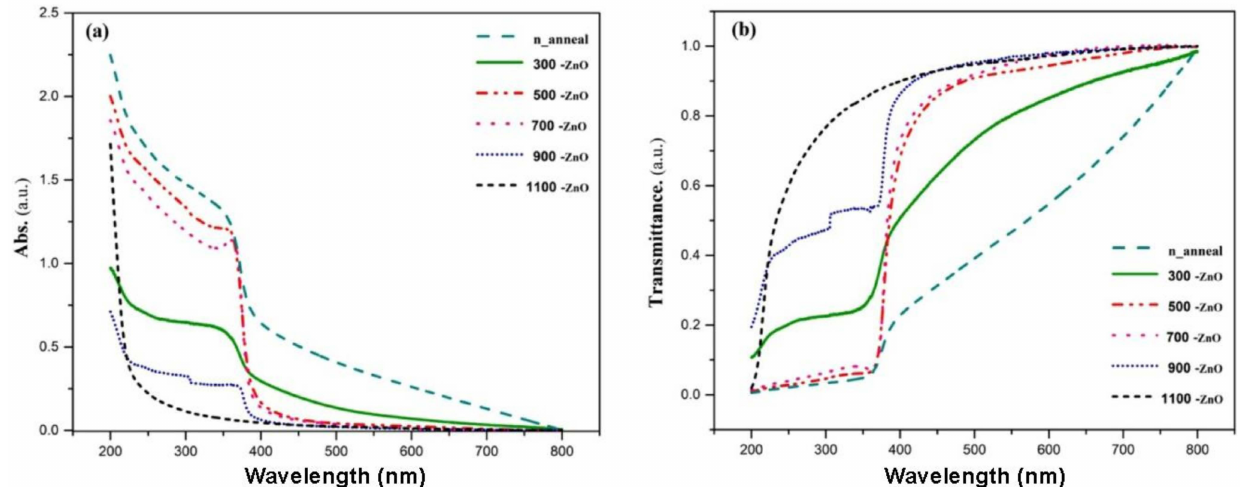
Figure 11. The absorption ( a ) and transmittance ( b ) spectra of the prepared thin films [86].